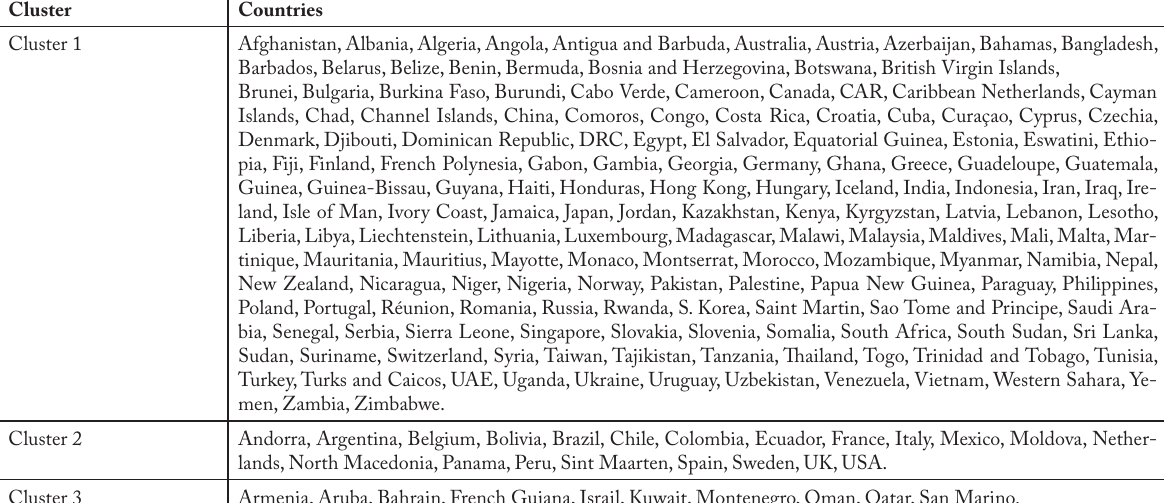
Table 6. Cluster memberships of countries according to the two step clustering.